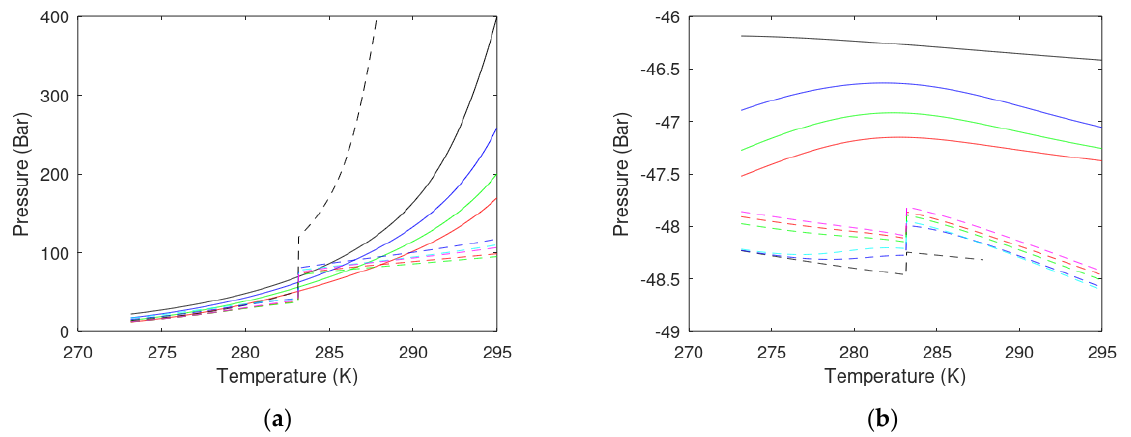
Figure 9. ( a ) Calculated pressure temperature stability limits for hydrates formed from pure CH 4 (black), from 99 mole% CH 4 and 1 mole% H 2 S (blue), from 99 mole% CH 4 and 2 mole% H 2 S (green), and from 99 mole% CH 4 and 3 mole% H 2 S (red). Dashed curves are for different compositions of injection gas. Black is for hydrate from pure CO 2 . Blue is for hydrate from 90% CO 2 and 10% N 2 . Cyan is for hydrate from 80% CO 2 and 20% N 2 . Red is for hydrate from 75% CO 2 , 20%N 2 , and 5% CH 4 . Green is for hydrate from 80% CO 2 and 20% N 2 . Red is for hydrate from 75% CO 2 , 23%N 2 , and 2% CH 4 . Red is for hydrate from 75% CO 2 , 15%N 2 , and 10% CH 4 . ( b ) Molar Gibbs free energy for hydrate from pure CH 4 and the 3 mixtures of CH 4 with H 2 S. Same color codes as in Figure 9 (a).